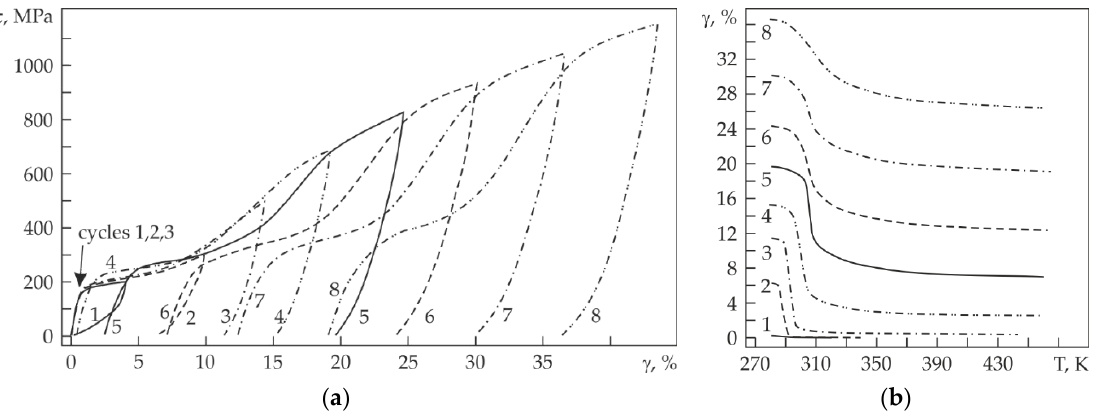
Figure 3. Accumulation and recovery of inelastic strain in loading–unloading cycles at 281 K ( a ) and its recovery on further heating ( b ).